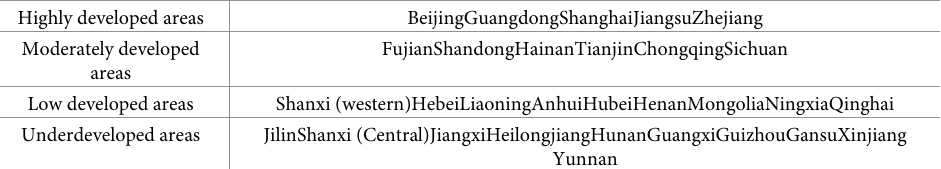
Table 3. Classification of China’s interprovincial digital economy development level clubs in 2019. Highly developed